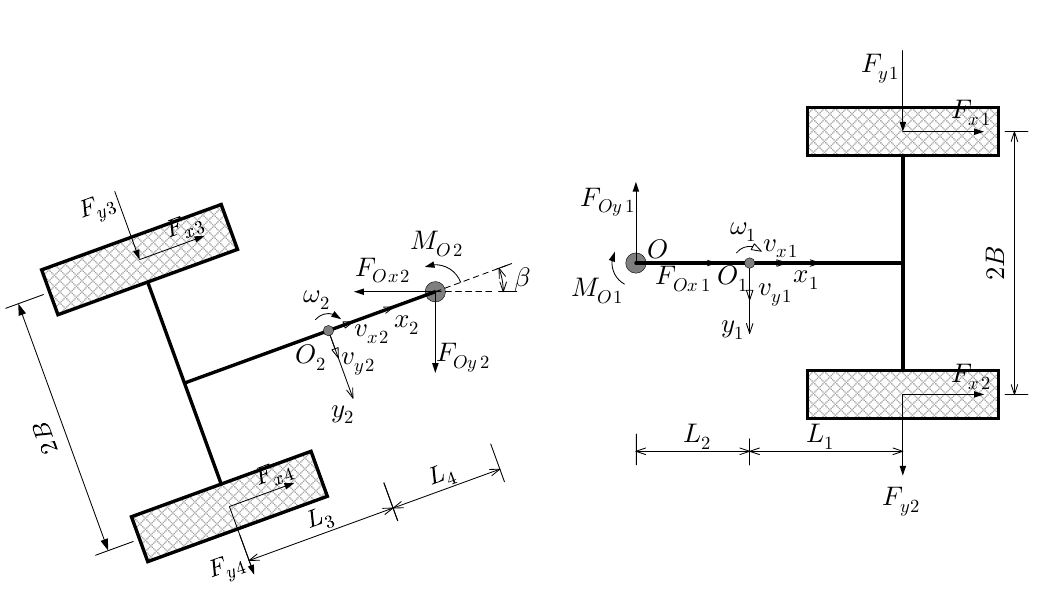
Figure 1. Articulated vehicle dynamics